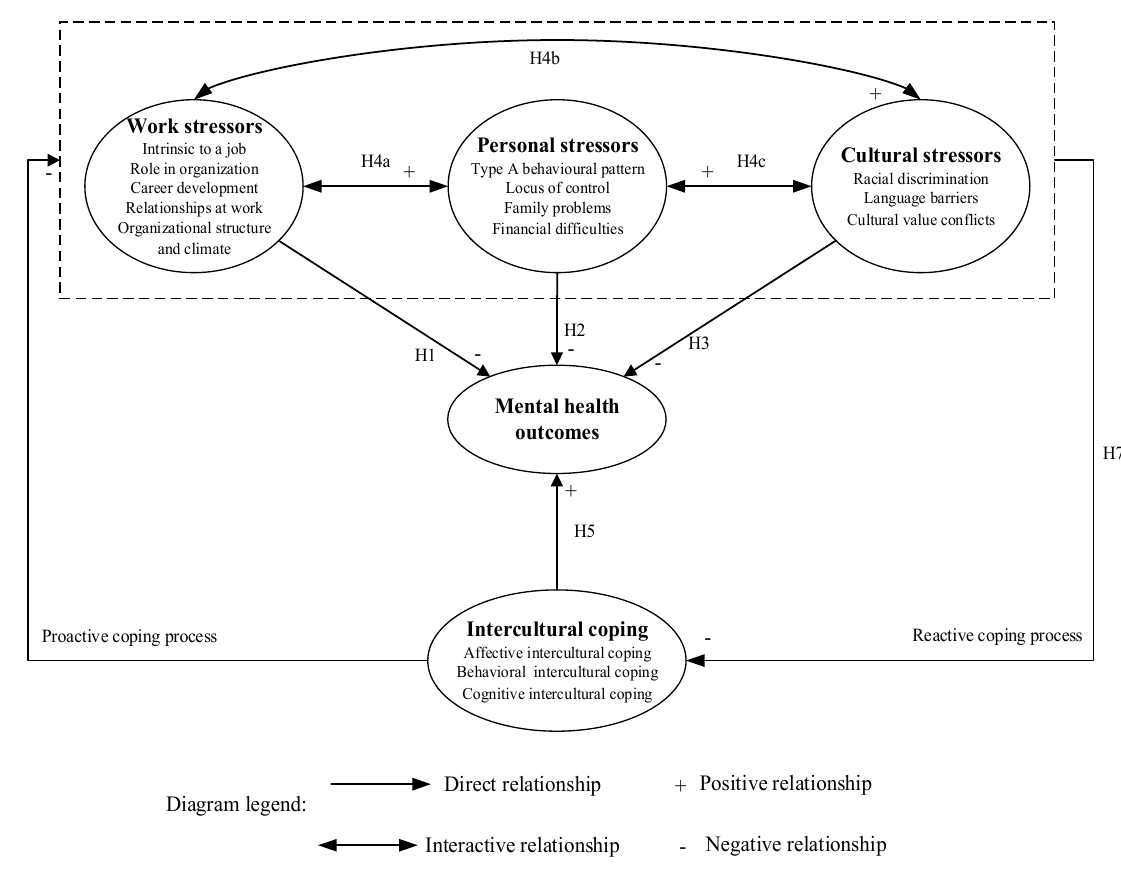
Figure 3. Conceptual model for managing mental health in a multicultural construction workplace.